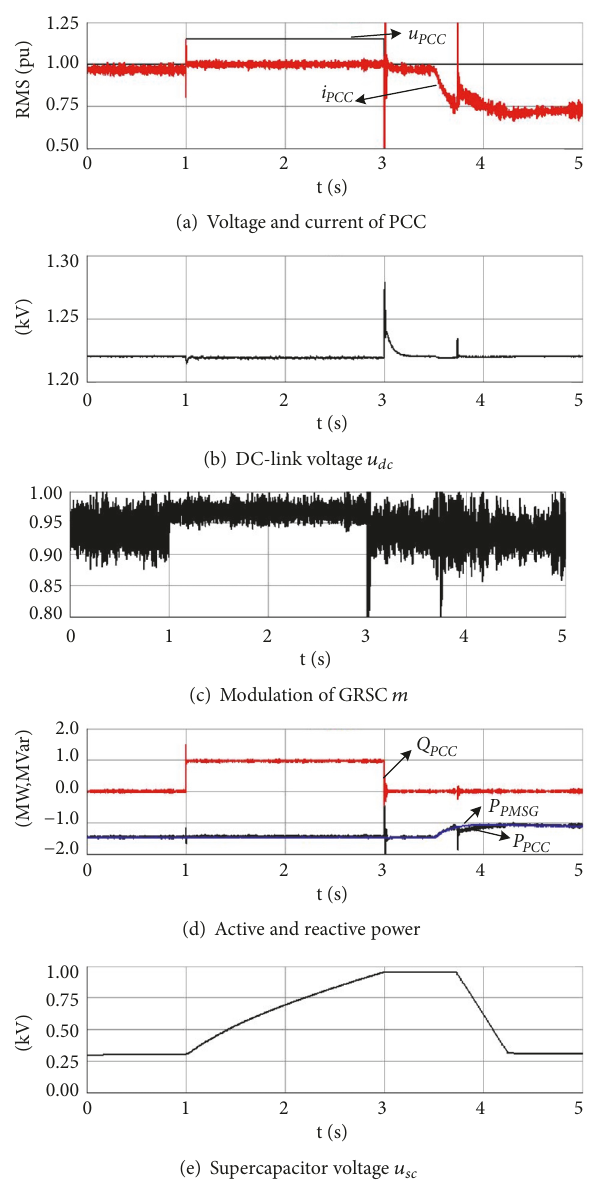
Figure 10: HiL results of GRSC with SCESU under voltage swell to